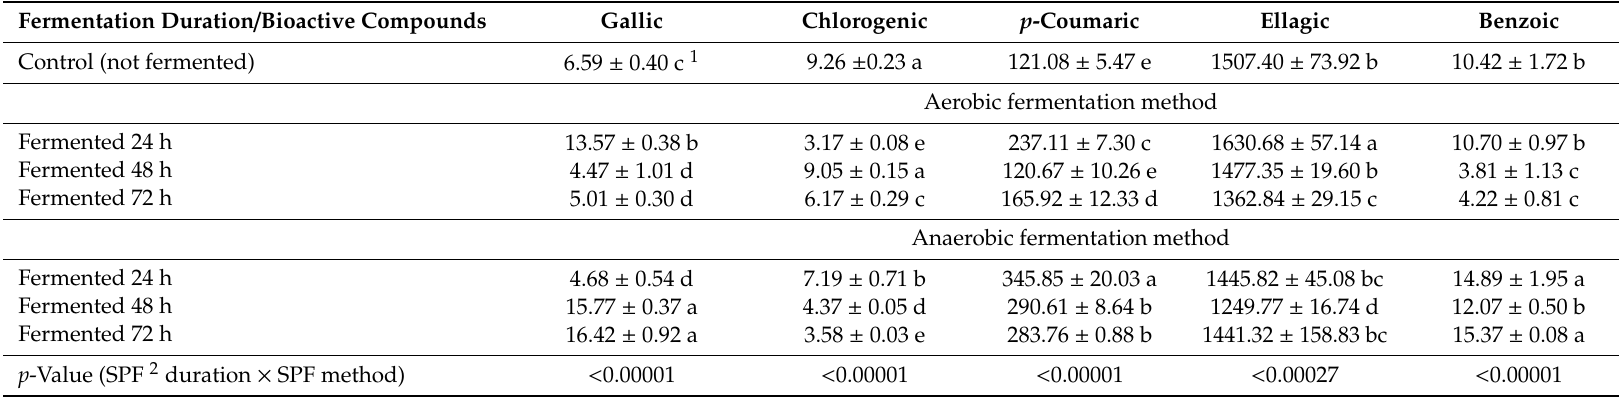
Table 4. The influence of SPF on the content of phenolic acids (mg 100 g − 1 DW) in organic willowherb leaves. Mean value ± standard error, n = 3.